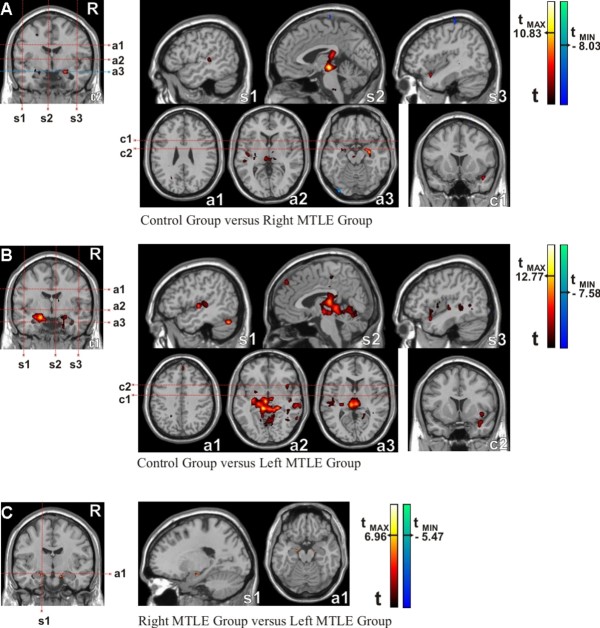
Functional Connectivity Maps (Intergroup comparison). Right seed: a) Control group versus Patients with Right MTLE, b) Control group versus Patients with Left MTLE, c) Patients with Right MTLE versus Patients with Left MTLE. Abbreviations - s1: first sagittal image; s2: second sagittal image; s3: third sagittal image; a1: first axial image; a2: second axial image; a3: third axial image; c1: first coronal image; c2: second coronal image. Statistical maps with t-scores higher than 6.